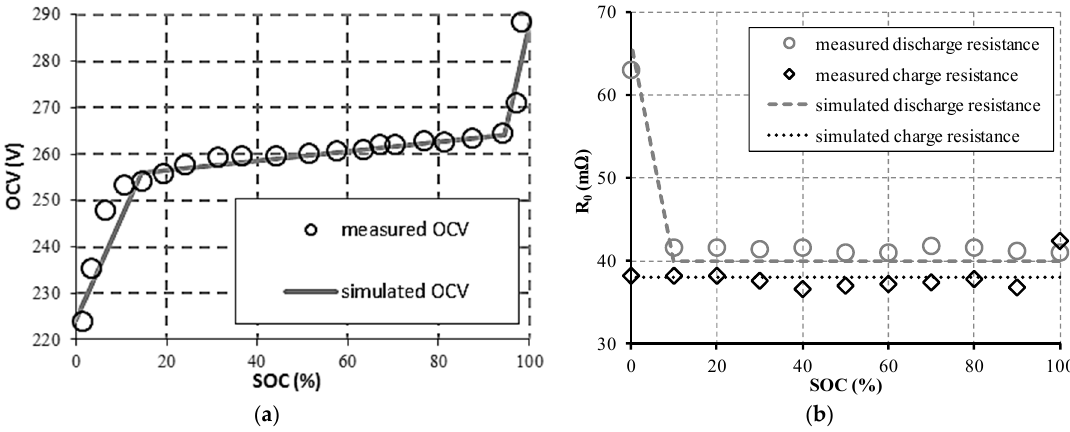
Figure 5. Measured and simulated parameter values for the Figure 4 model, as a function of state-of-charge (SOC). ( a ) No-load voltage E m ; and ( b ) charge and discharge resistances R 0, c and R 0, d .